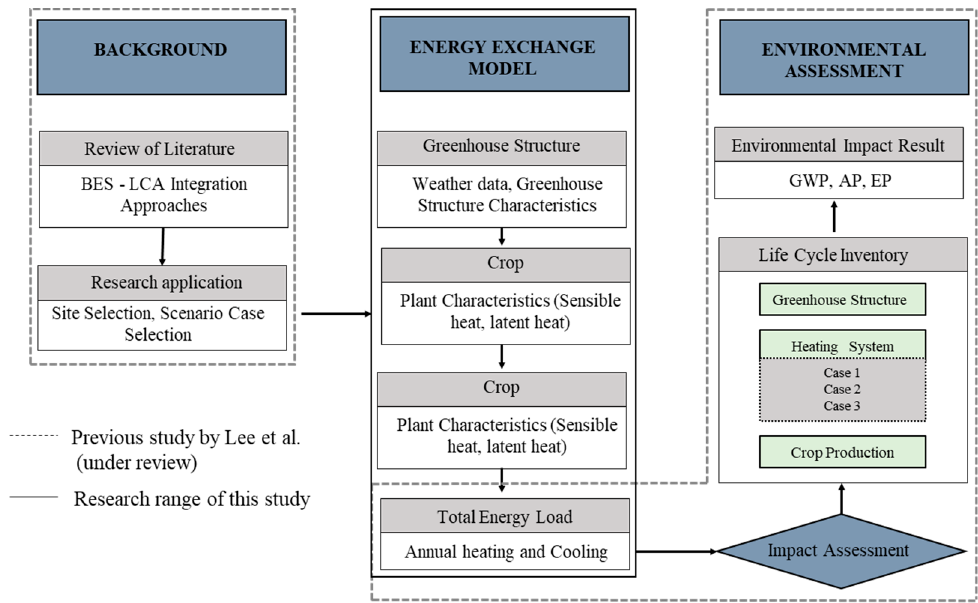
Figure 1. Research flow for integrated BES–LCA approach for environmental assessment of green- house heating system.